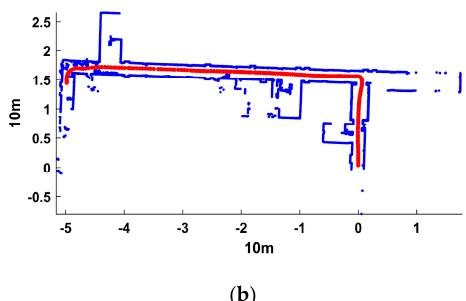
Figure 14. ( a ) Matching result from the standard MbICP algorithm; ( b ) matching result from the improved MbICP algorithm.